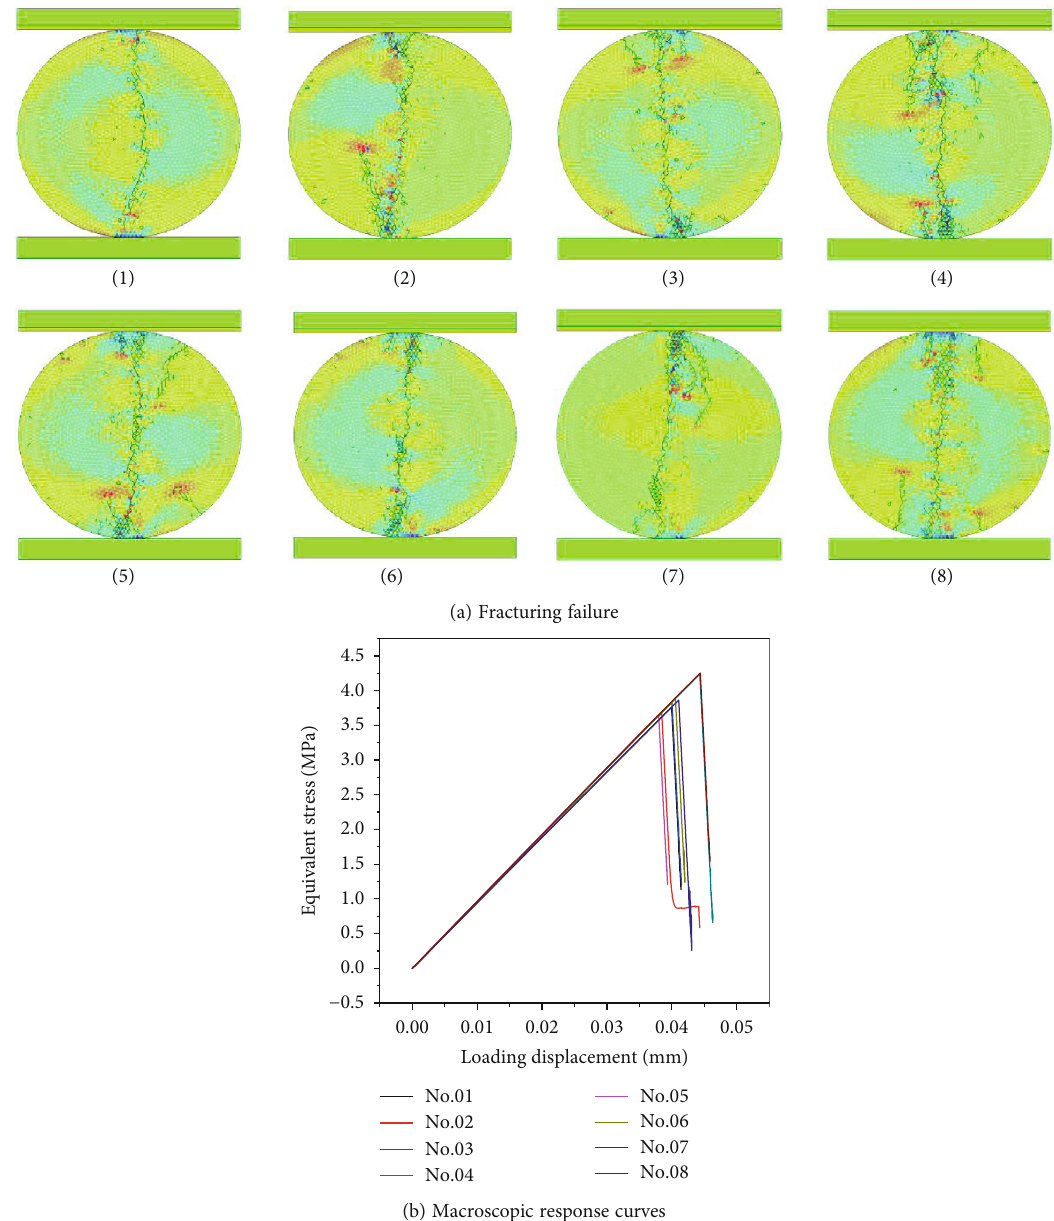
Figure 6: Simulation results of the disc when m = 5 . Table 3: Peak strength discreteness of rock discs. Model type